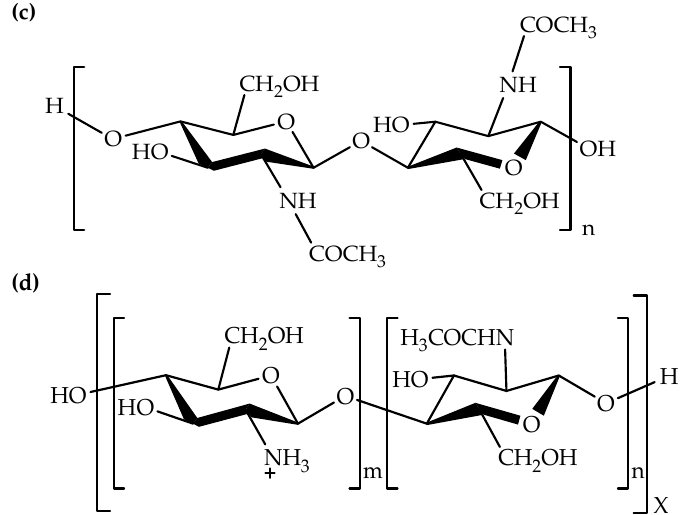
Figure 1. Chemical structures of ( a ) cellulose, ( b ) cellulose acetate, ( c ) chitin, and ( d ) chitosan.